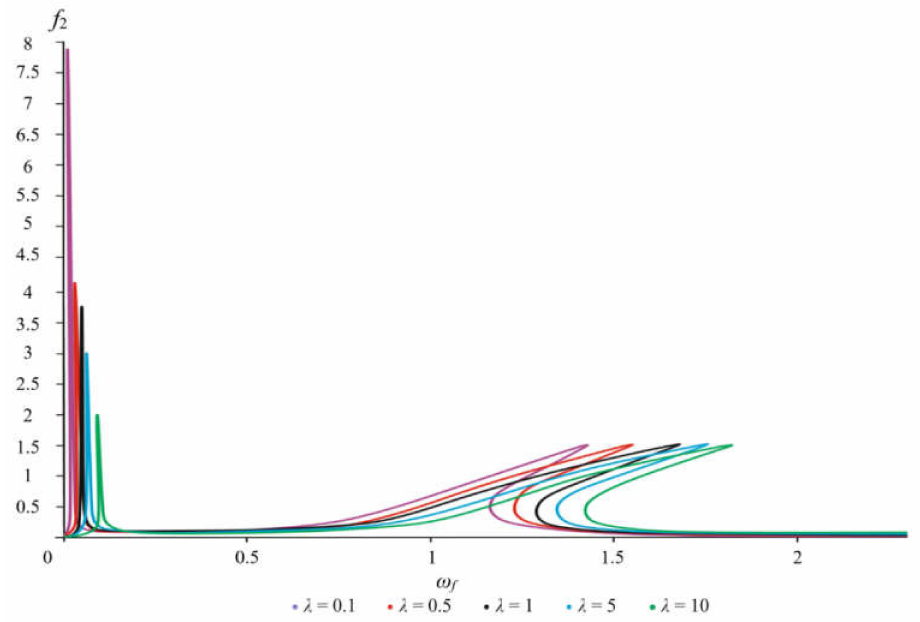
Figure 12. The amplitude-frequency characteristic of the foundation for different ratios of stiffness